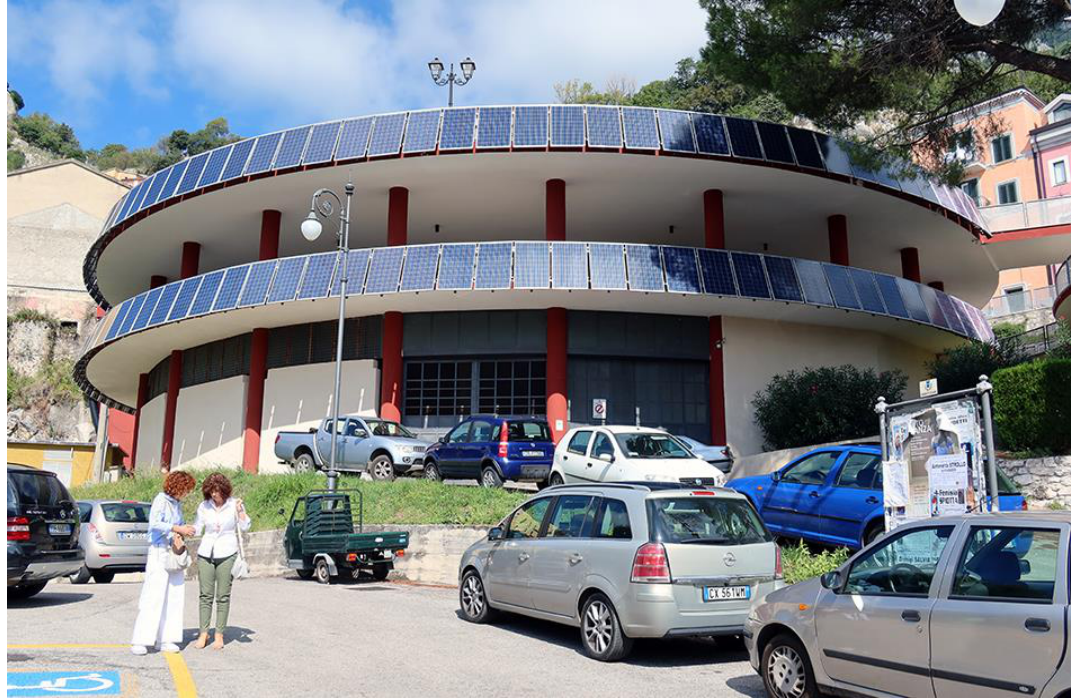
Figure 81. Colliano: modern access structure with lift to Piazza Epifani (photos by [35,36]).